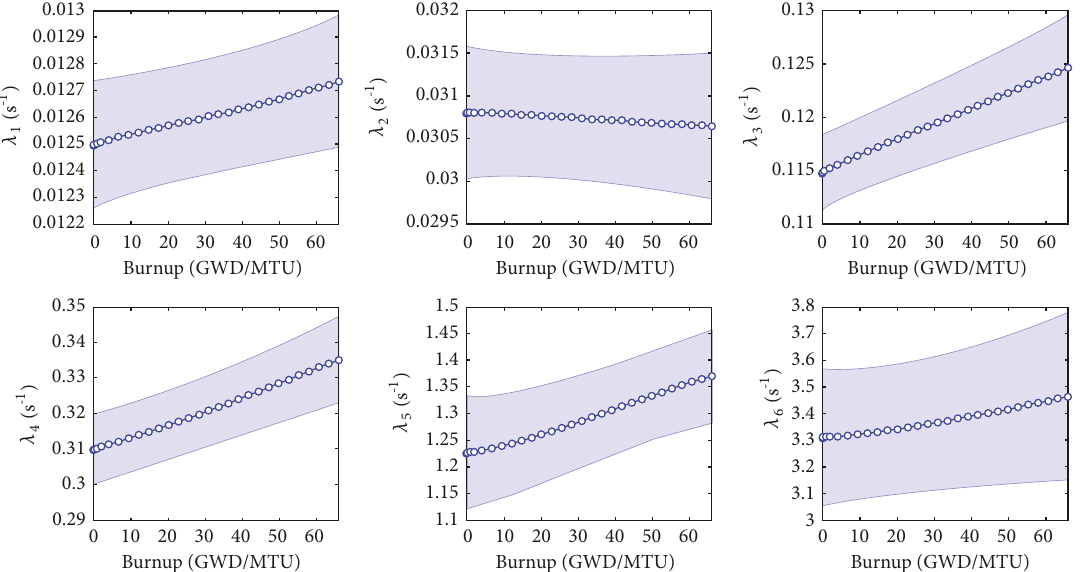
Figure 7: Variation of the precursor-group-wise decay constant ( 𝜆 𝑖 ) as a function of burnup plus 1𝜎 uncertainty for the PWR lattice.